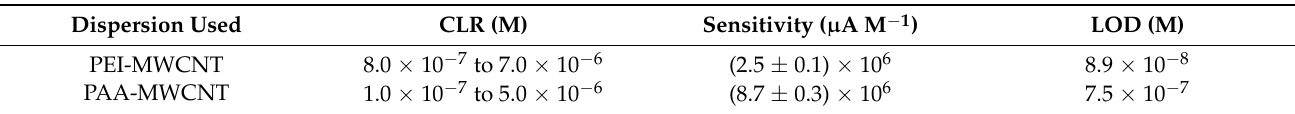
Table 2. Analytical parameters obtained for PEI-MWCNT/GCE and PAA-MWCNT/GCE sensors for the quantification of QER by adsorptive stripping with SWV detection. See the abbreviation list at the end of the article. Dispersion